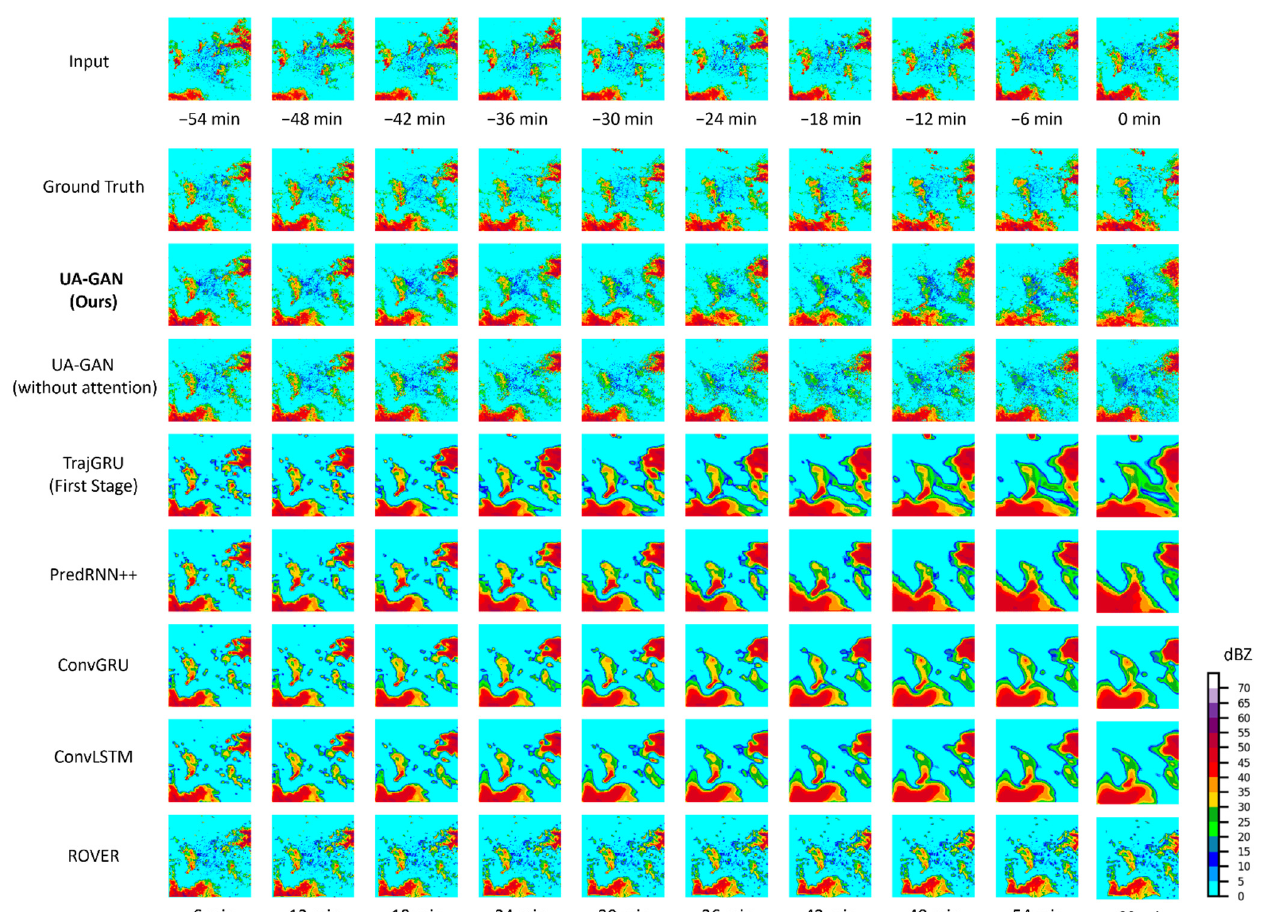
Figure 8. Visualization example of the predicted echo maps using different methods. The input echo sequence is 24 May 2015, from 02:48 to 03:48, and the predicted sequence is from 03:54 to 04:54.